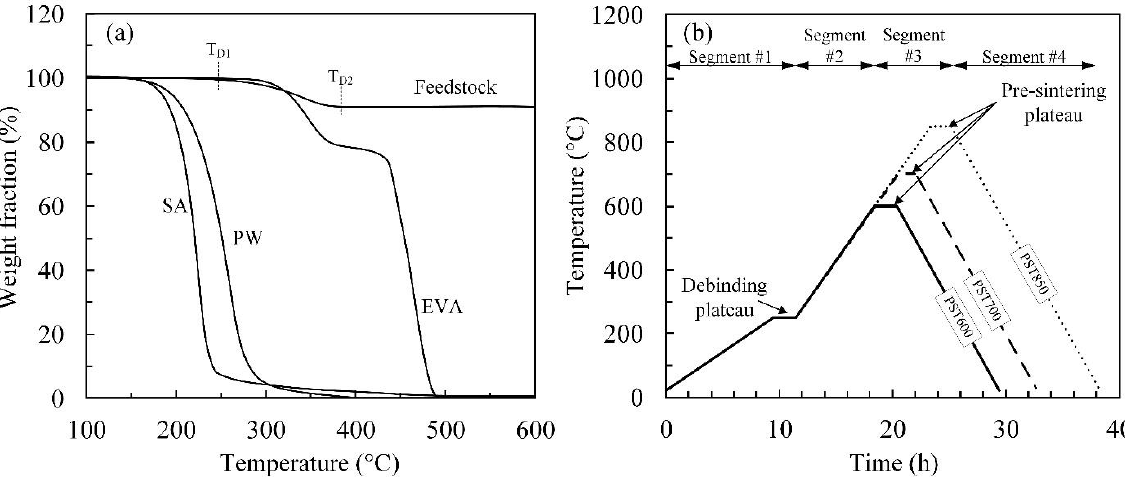
Figure 5. ( a ) TGA profiles of binder constituents (SA: stearic acid; PW: paraffin wax; EVA: ethylene vinyl acetate) and feedstock, and ( b ) thermal wick debinding cycles performed at different pre-sintering temperatures varying from 600 to 850 °C under argon atmosphere.